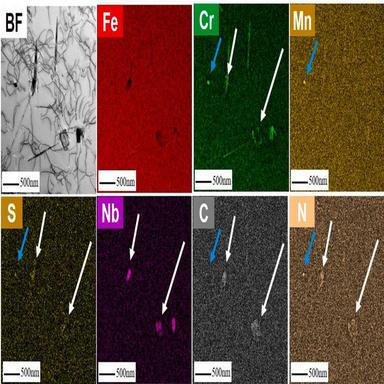
TEM images show Stacking Fault after creep test of Alloy 709 under 150 MPa at 700 ◦C enriched in chromium and fine scale Nb(C,N) precipitates according to Chemistem Scan for 709,700 ◦C Creep Test.